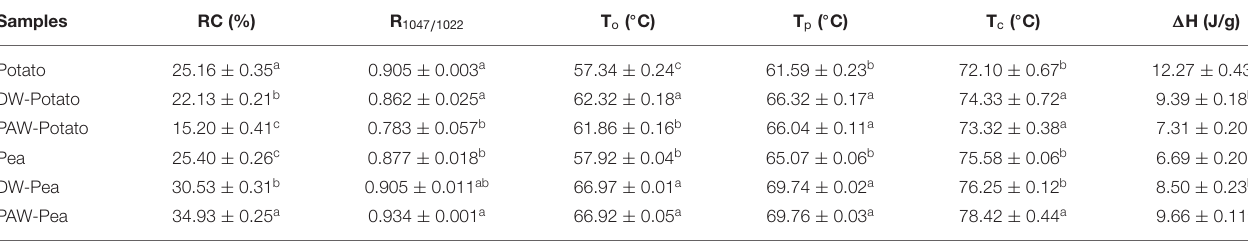
TABLE 2 | Long-range, short-range ordered structure, and thermal properties of native and modified starches. Samples RC (%) R 1047 / 1022 Potato DW-Potato PAW-Potato Pea